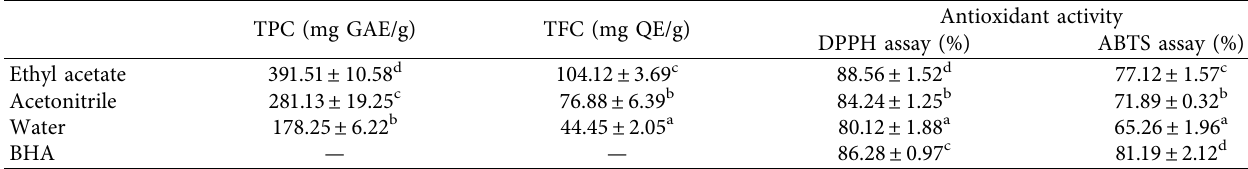
Table 1: Total phenolic and flavonoids contents and antioxidant activity of the ethyl acetate, acetonitrile, and aqueous extracts of Punica granatum (pomegranate)